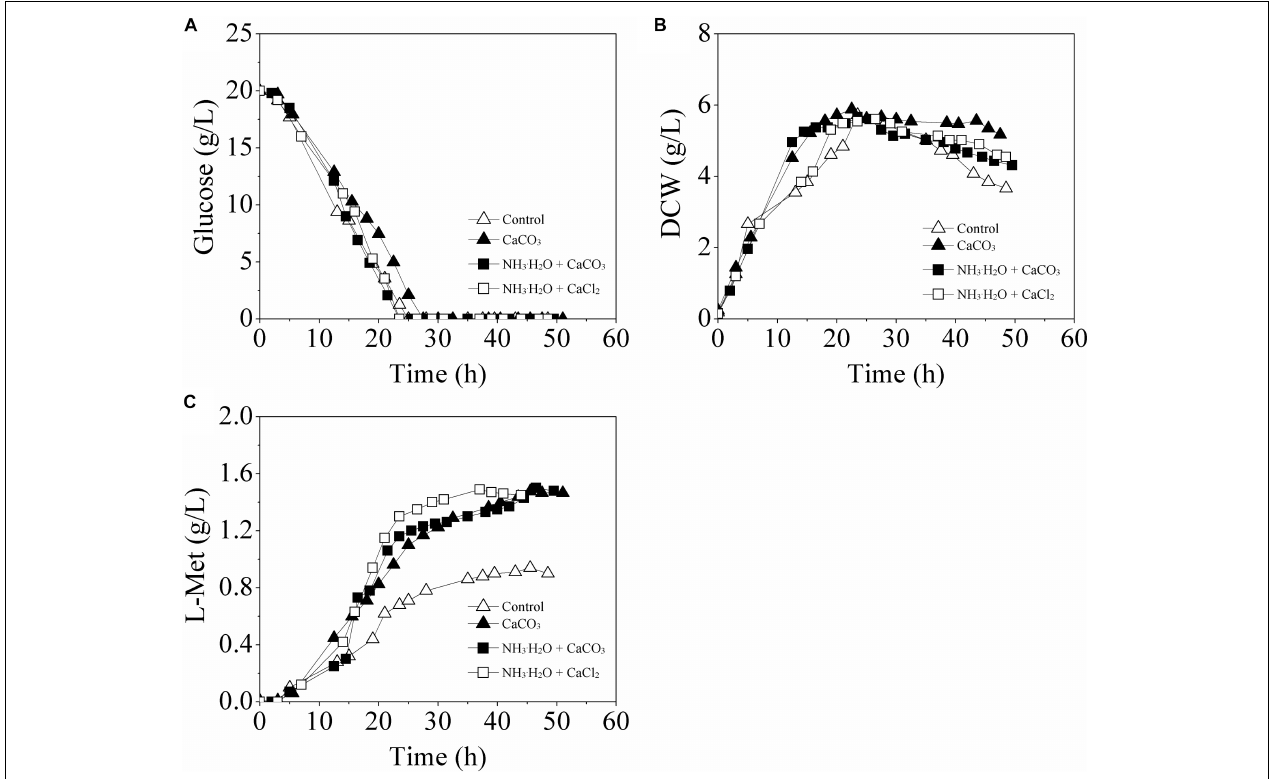
FIGURE 3 | Time course of L -Met fermentation by the genetically engineered E. coli W3110-BL in batch cultures with different pH control modes. (A) glucose consumption; (B) cell growth; (C) L -Met biosynthesis. All measurements were performed in triplicate. For clarity, the error bars were not displayed.